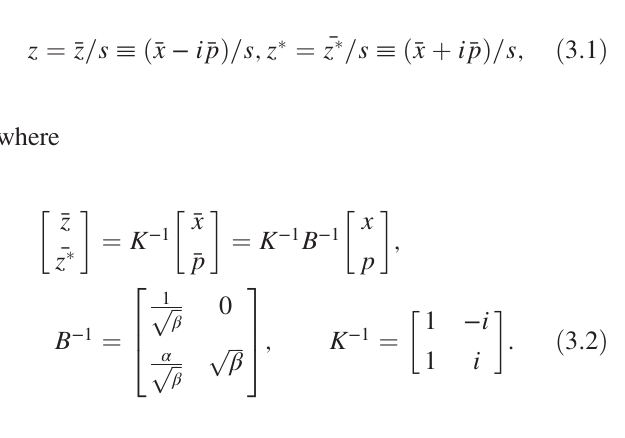
FIG. 3. Curves (blue) with constant j w phase space compared with the result of tracking one turn